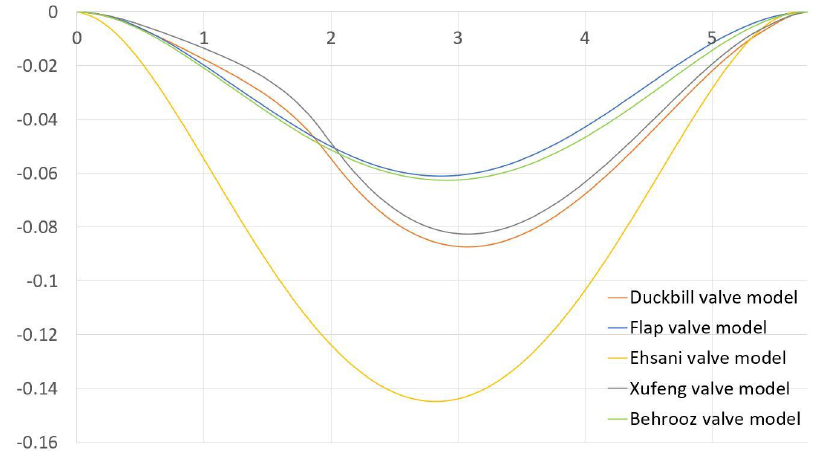
is completed. The fluid domain and solid parts are at rest initially for all five models.